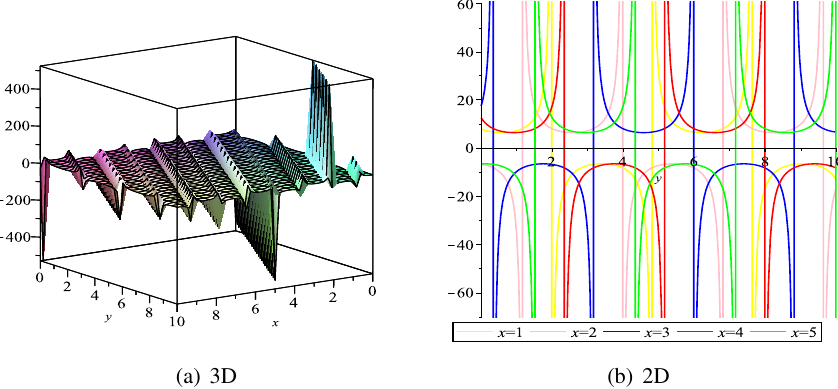
Fig. 5 The singular periodic solution (88) for k 1 = − 1 . 5 , k 2 = 0 . 75 , k 3 = 1 , c 2 = 1 . 1 , δ = − 1 . 2 , α = 1.